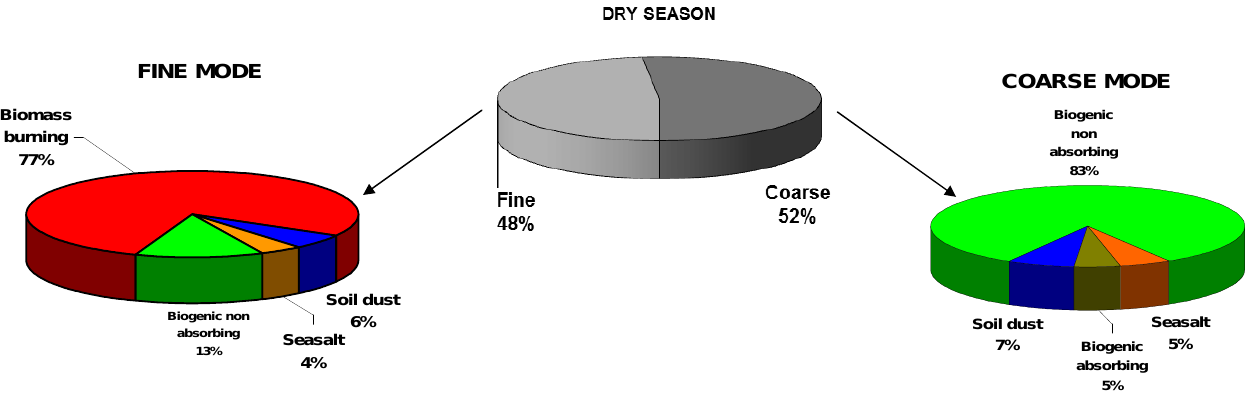
Fig. 10. The same as the previous figure but for the 2nd semester. The mean concentrations were 7.2 ± 2.1µgm − 3 for the coarse mode and 6.2 ± 3.1µgm − 3 for the fine